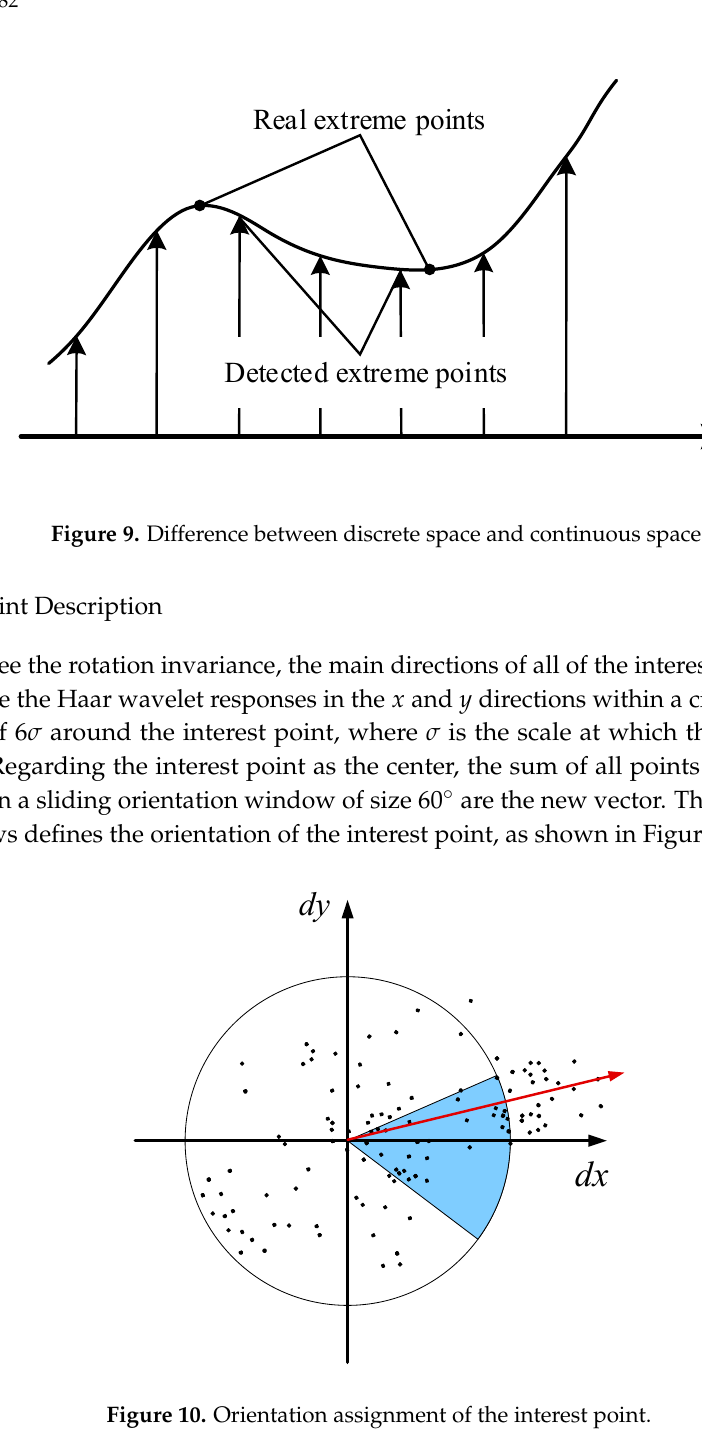
Figure 10. Orientation assignment of the interest point.